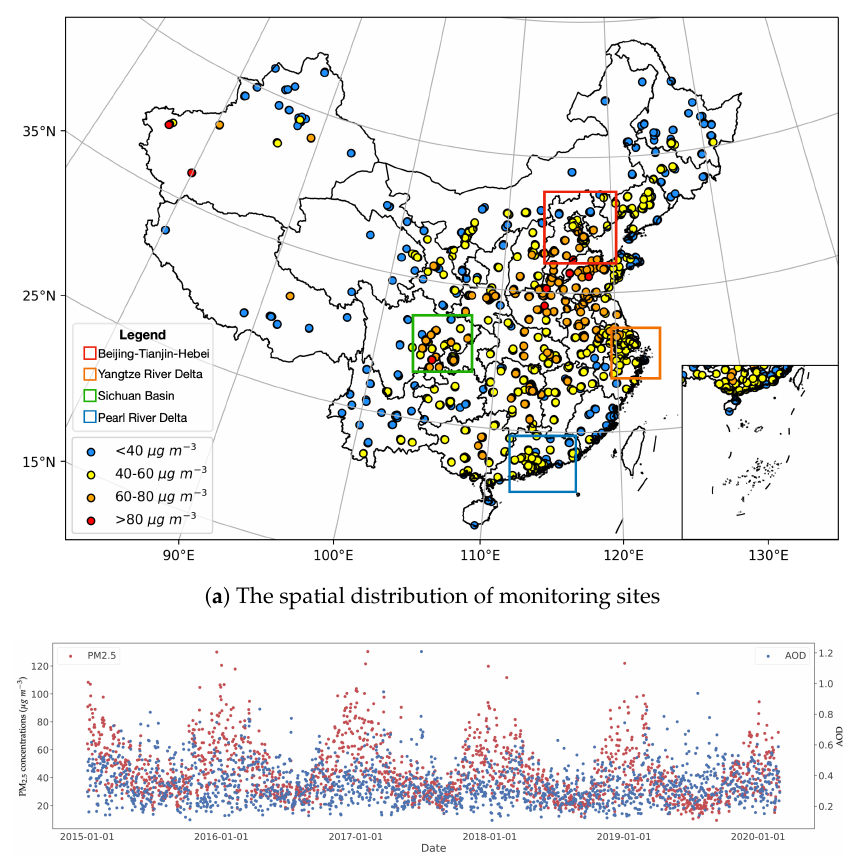
Figure 1. ( a ) The spatial distribution of monitoring sites. The monitoring stations are illustrated as points and the color of the scattered point indicates the average of the PM 2.5 concentration ( µ g m − 3 ) from 2015 to 2019. ( b ) Scatter plot of the daily average PM 2.5 concentrations ( µ g m − 3 ) and daily average aerosol optical depth (AOD) of all observation sites from 2015 to 2019. The PM 2.5 concentrations have notable seasonal variations, but the fluctuation of AOD is relatively